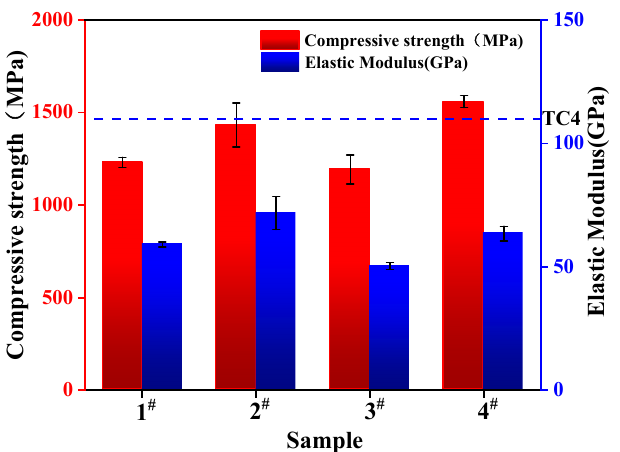
Figure 6. The compressive strengths and elastic modulus of Ti-40Nb-10Ag (1 # , 2 # , 3 # ) for different sintering temperatures and Ti-40Nb alloy (control group-4 # ).